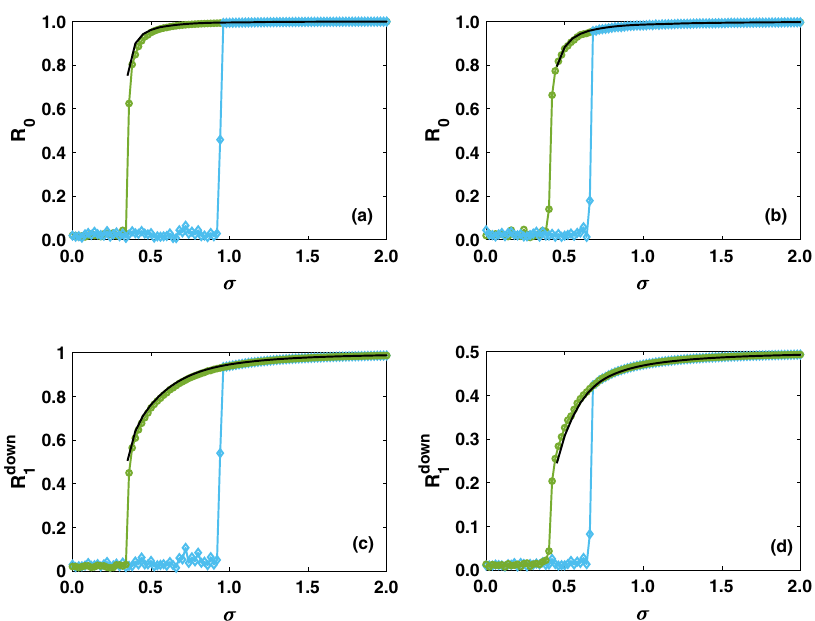
Fig. 4 Comparison between the simulation results of the Nodes-Links (NL) Model and its solution in the annealed approximation. The hysteresis loop for the synchronization order parameters R 0 and R down of the NL Model are shown as a function of σ for a Poisson network with average degree c = 12 ( a , c ) 1 and for an uncorrelated scale-free network with minimum degree m = 6 and power-law exponent γ = 2.5 ( b , d ). Both networks have N = 1600 nodes. The symbols indicate the simulation results for the forward (cyan diamonds) and the backward (green circles) synchronization transition. The solid black lines indicate the analytical solution for the backward transition obtained by integrating Eq.